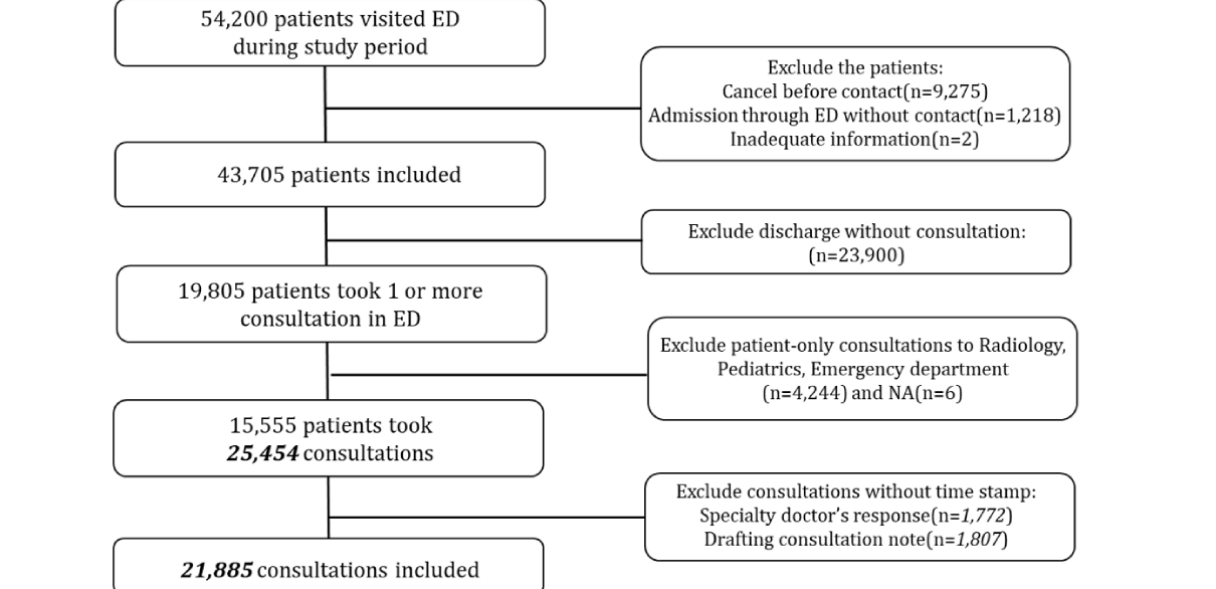
Figure 3. Flowchart of patient inclusion in the specialty consultation process. ED: emergency department; NA: No information about consultation